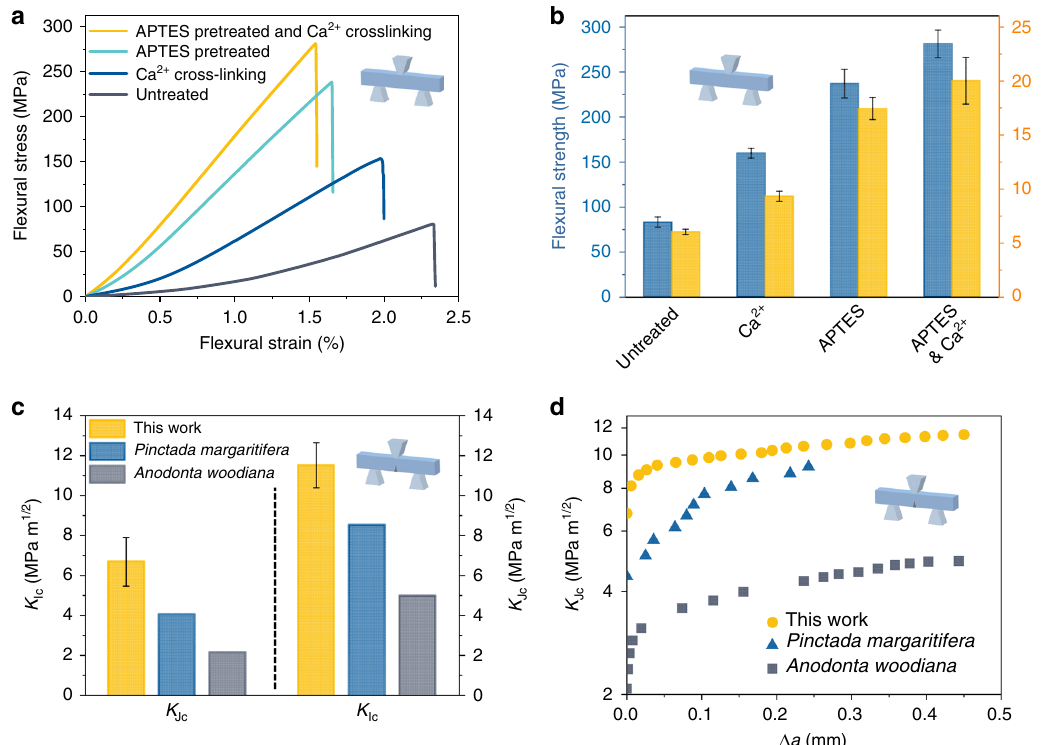
Fig. 2 Mechanical properties of the all-natural bioinspired structural material. a Flexural stress – strain curves of all-natural bioinspired structural material with different pretreatments. b Comparison of fl exural strength and stiffness of all-natural bioinspired structural material with different pretreatments. Error bars represent standard deviation. c Fracture toughness for crack initiation ( K Ic ) and steady-state ( K Jc ) of the all-natural bioinspired structural material and some natural nacre 18 . Error bars represent standard deviation. d Rising crack-extension resistance curves (evaluated by the steady-state fracture toughness K 18 Jc ) of the all-natural bioinspired structural material and some natural nacre